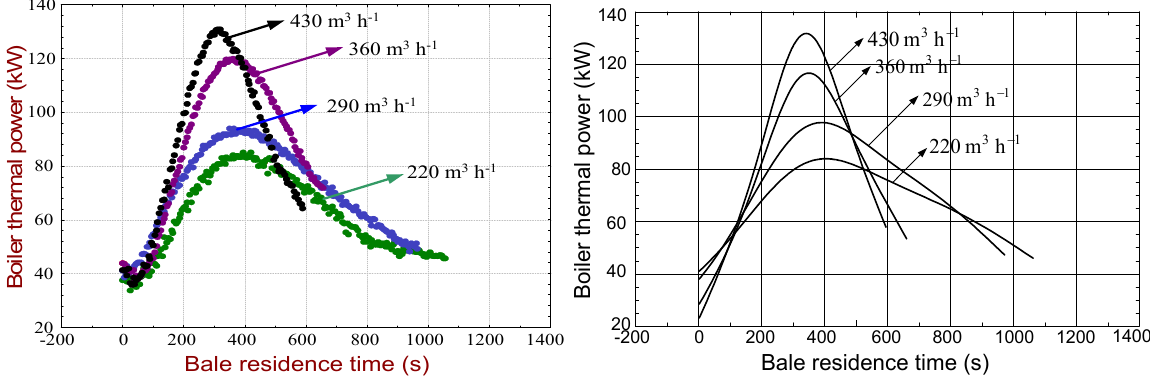
Figure 3. ( a ) Correlation between boiler thermal power and bale residence time, experimental data, recirculation 0%; ( b ) Correlation between boiler thermal power and bale residence time, model (1), recirculation 0%.